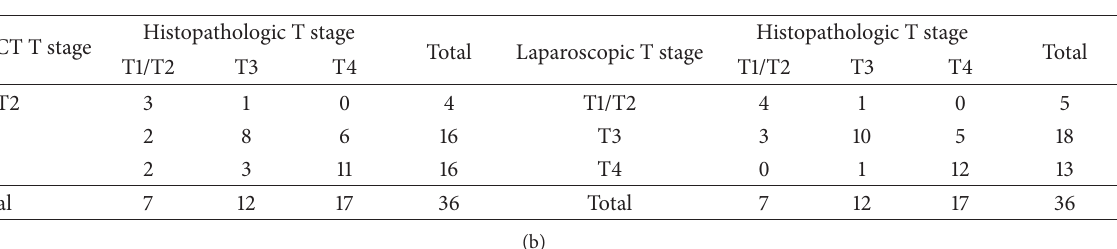
Table 2: CECT/laparoscopic vis-a-vis histopathologic T and N staging. (a)